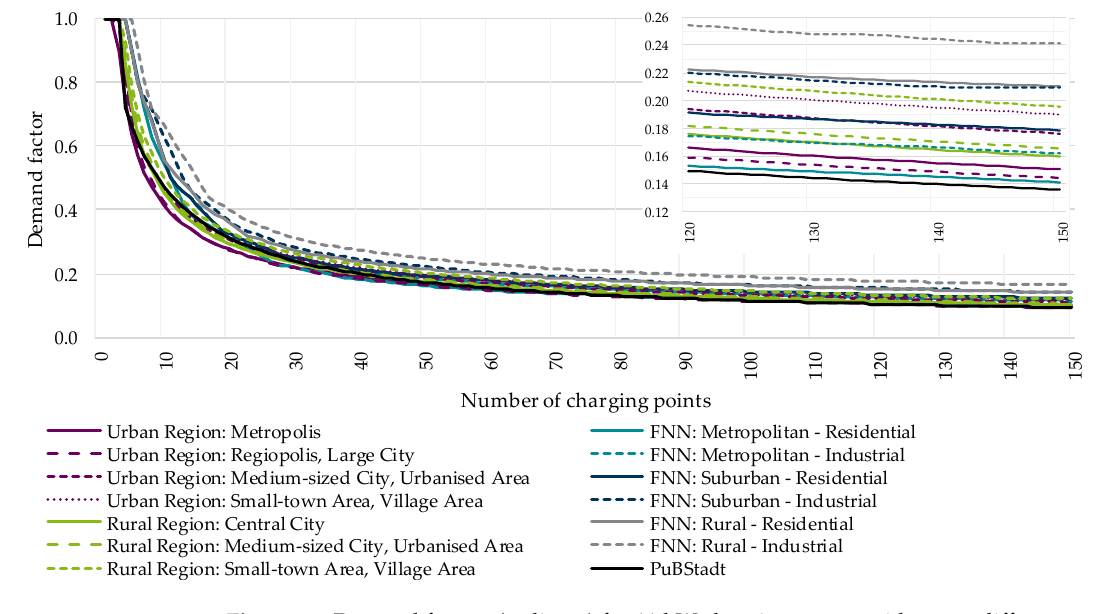
Figure 24. Demand factors (ordinate) for 22 kW charging power with seven different area types, six area types according to FNN and the results from PuBStadt for 150 charging points.